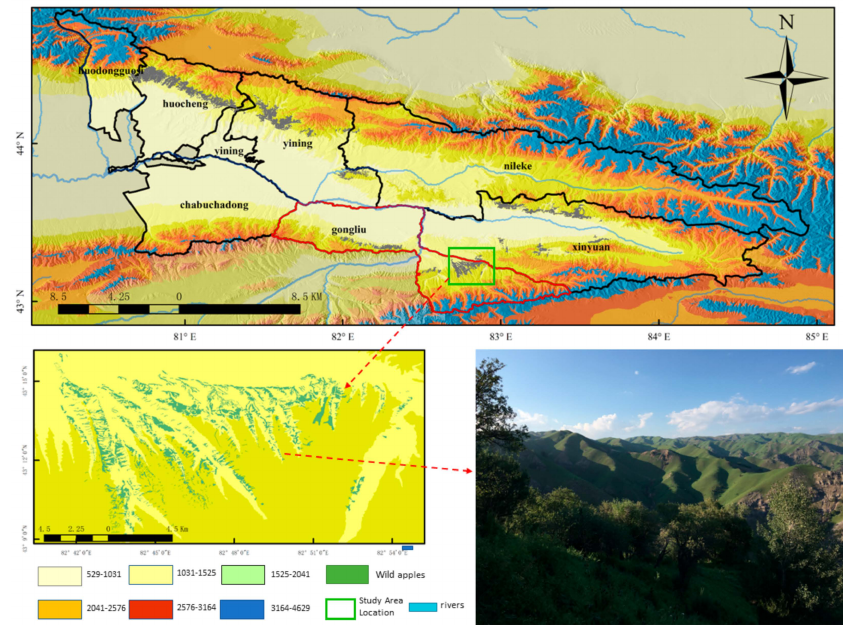
Figure 1. Location distribution of the study